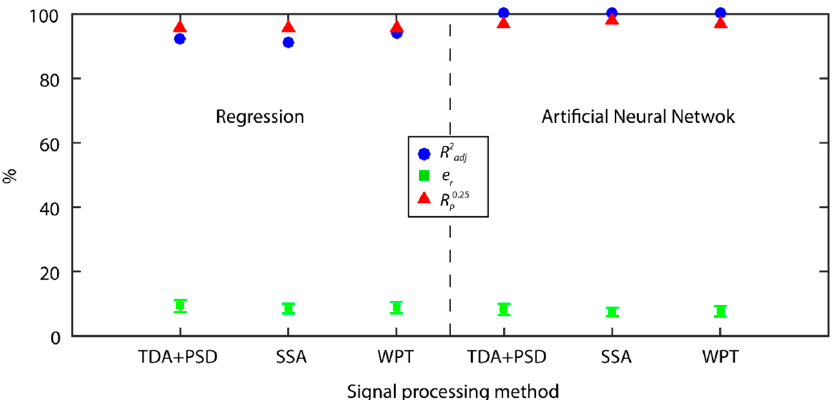
Figure 20. Prediction results for the MR and ANN models with multi-sensor data fusion of cutting force and vibration signals.